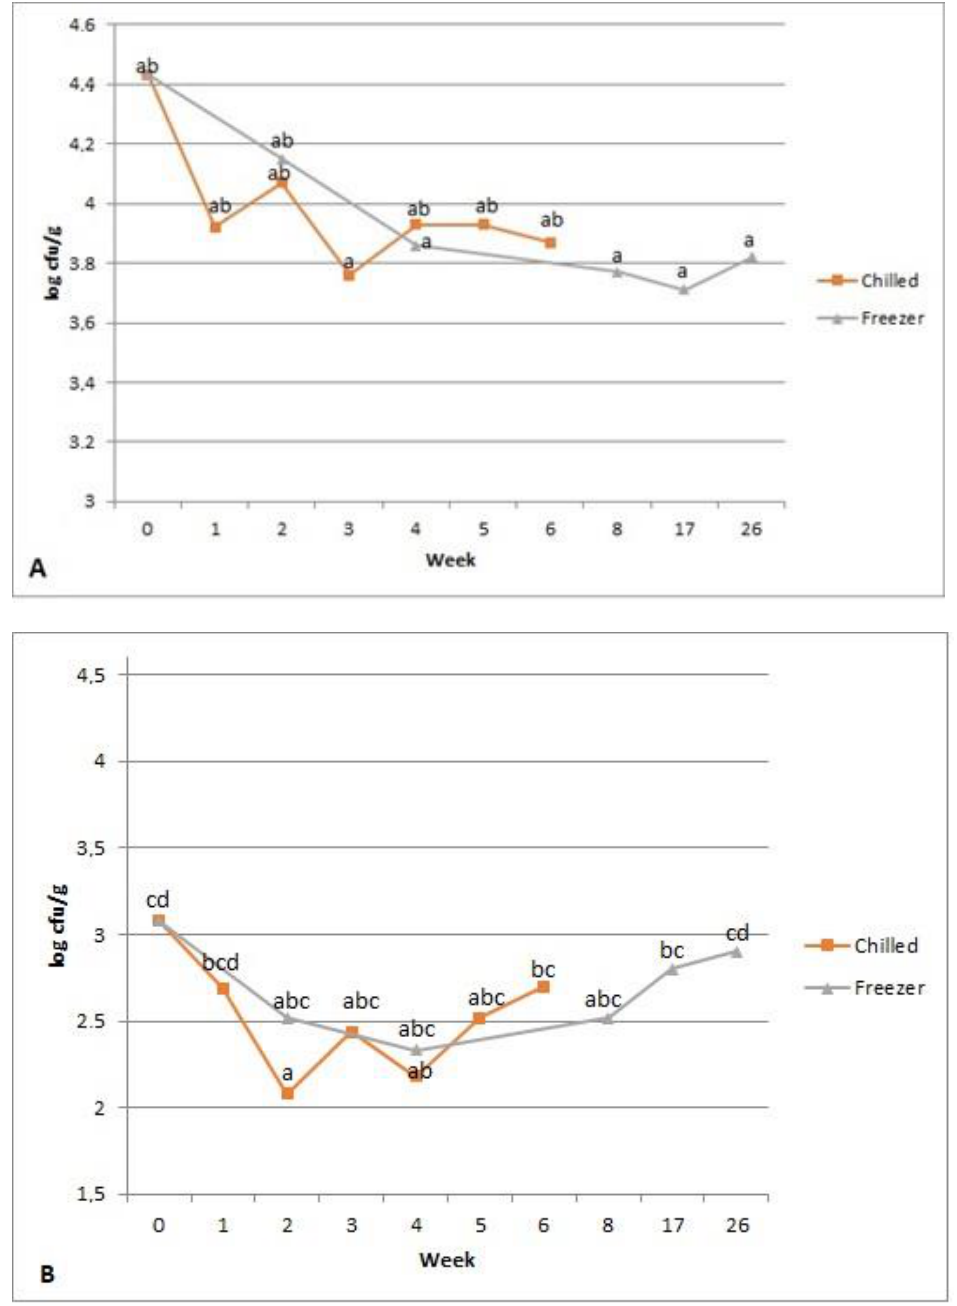
Figure 3. Microbiological quality of innovative snacks with CSGH stored in different conditions. ( A ) Total viable aerobic (TVC) count, ( B ) yeast and mold (YM). Results presented as mean; a,b,c,d — results marked with varied lettering are significantly different.